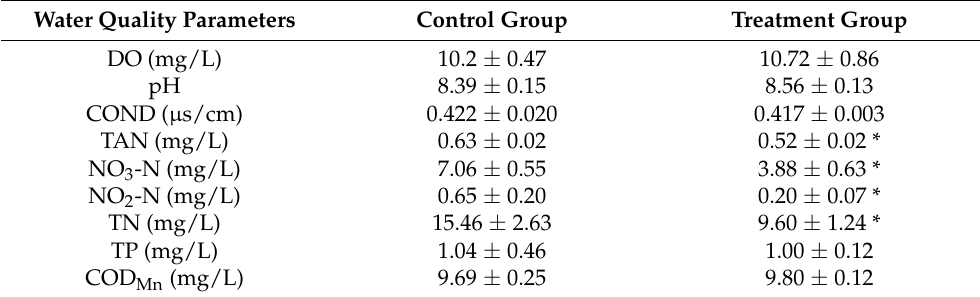
Table 1. Water quality parameters in different groups at the end of the experiment.